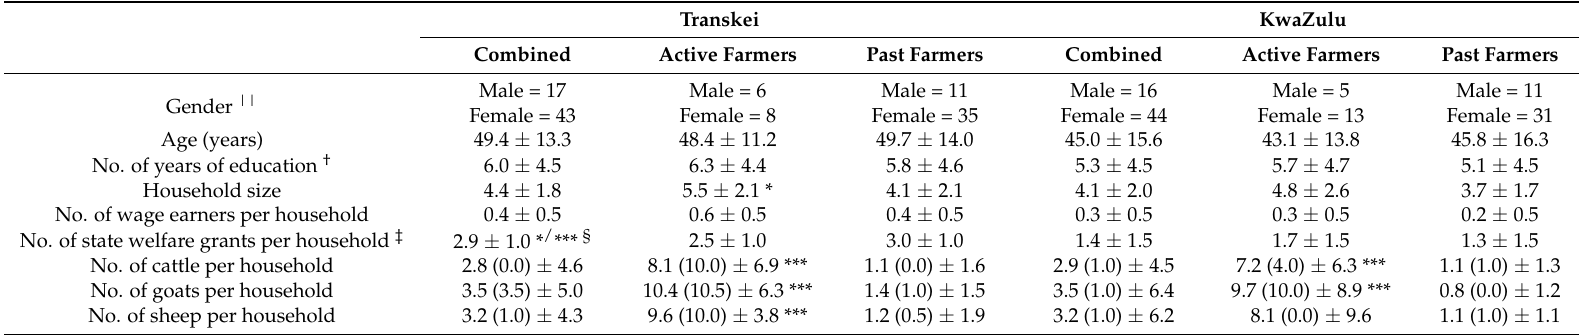
Table 2. Interview respondents’ demographic and livelihood profiles (mean ± SD). Livestock numbers are reported as mean (median) ± SD to demonstrate within group variation in